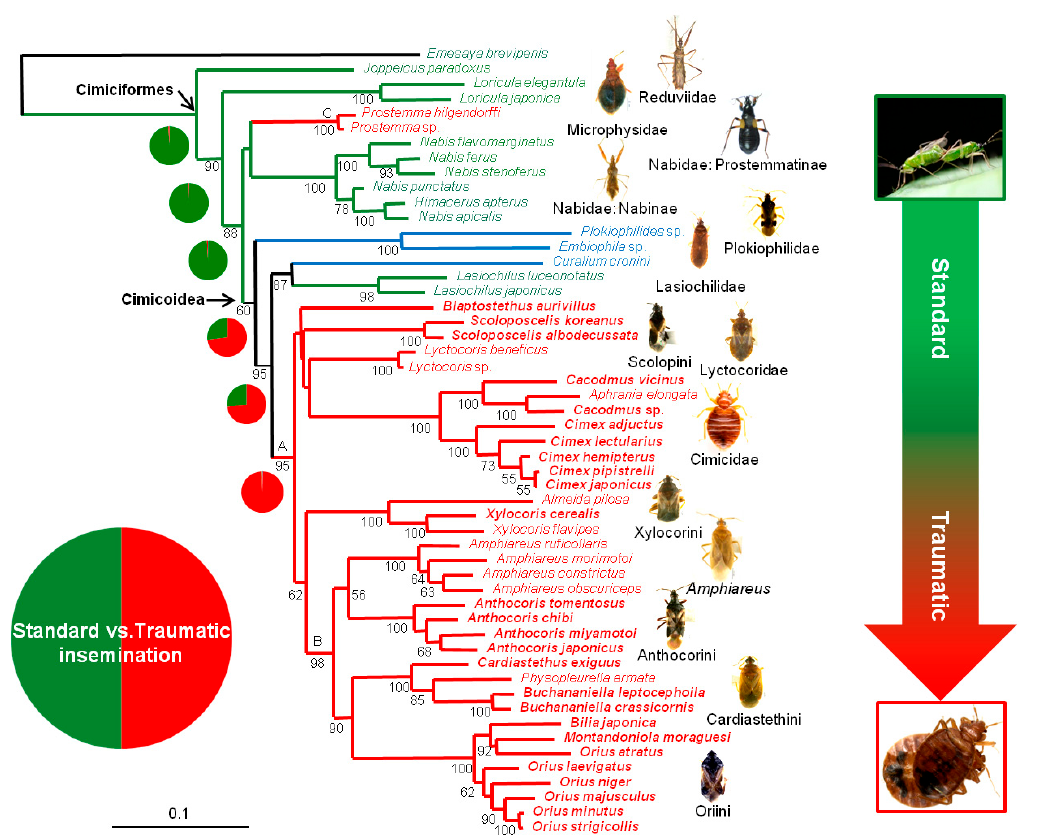
Figure 3. Maximum likelihood tree and ML bootstrap support values (>50%). Traumatic insemination (TI) clades and taxa highlighted in red; standard insemination clade and taxa highlighted in green. Uncertain taxa and clades in terms of their copulating habits highlighted in light blue. Taxa in bold indicate whose females evolved PG. Reconstructions of ancestral copulating method using BayesTraits are indicated as pie charts that shows the posterior probabilities of each type at the respective nodes representing higher-taxa relationships.